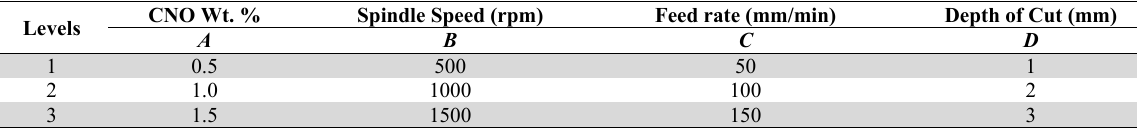
Process constraints CNO Wt. % Levels